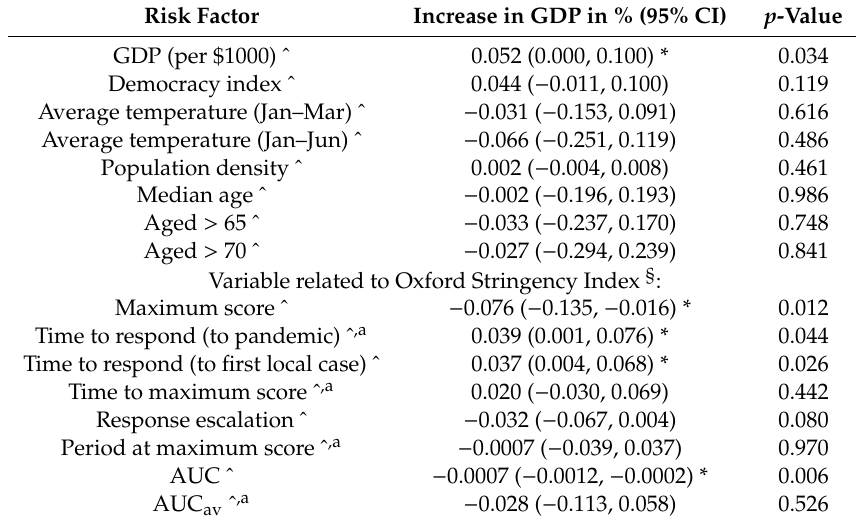
Table A3. Results of linear regression models on change in annual growth rate 2019–2020 due to a double-hit scenario (38